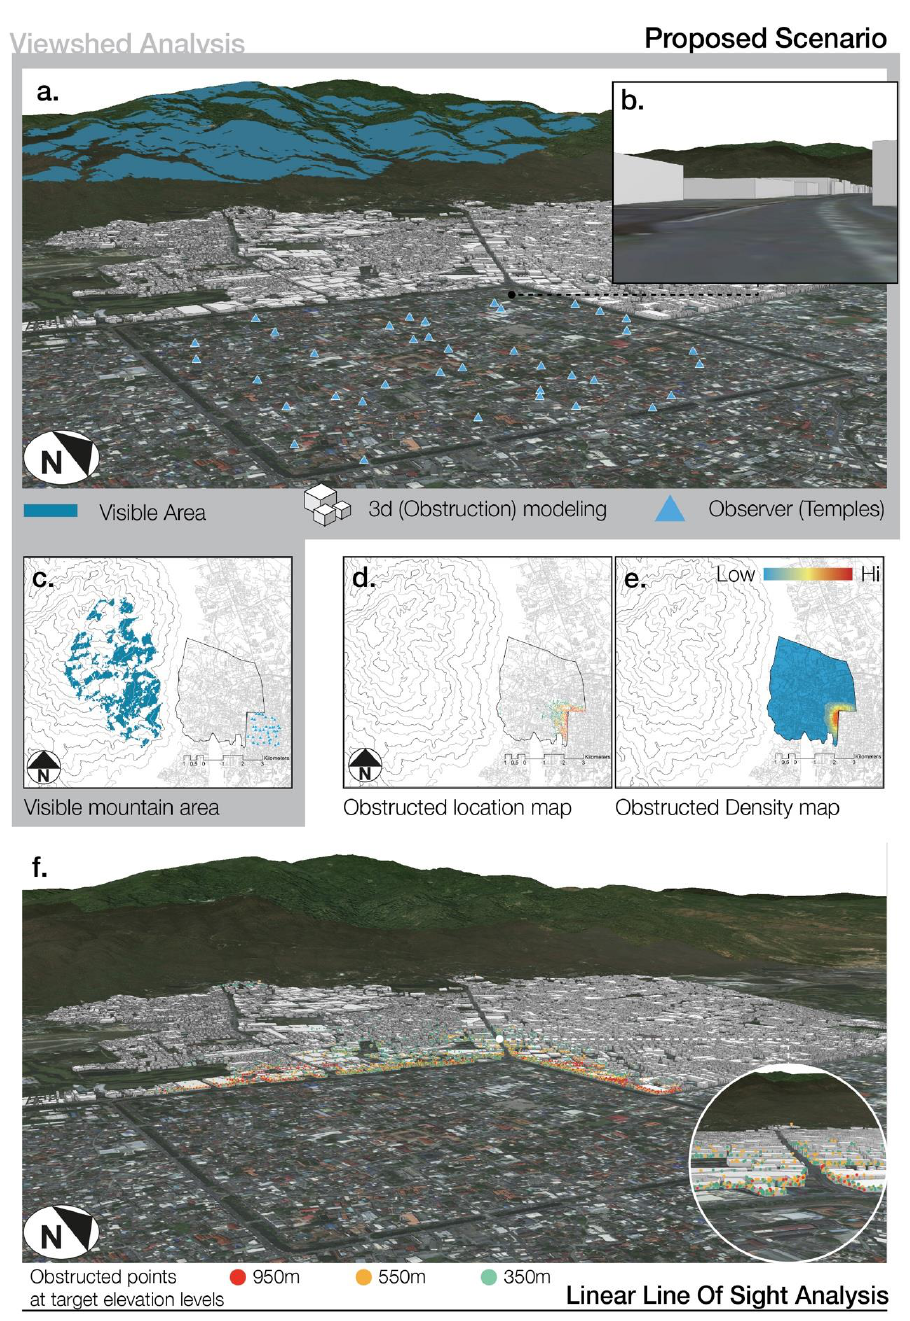
Figure 13. Results of the Proposed Scenario ( a ) Viewshed result in 3D ( b ) A sample view at human eye-level ( c ) Viewshed map ( d ) Obstructed location map ( e ) Obstructed density map ( f ) Obstructed locations at three elevation levels (Source: Authors).